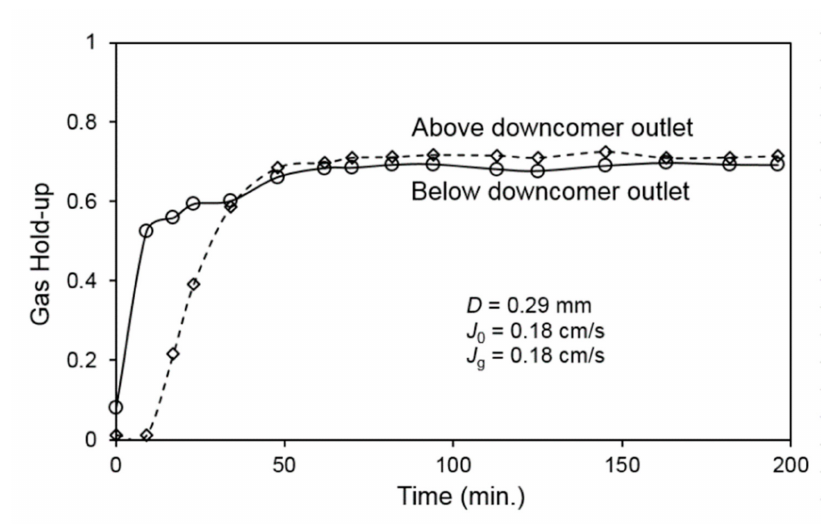
Figure 3. Gas holdup values in the system approaching steady state